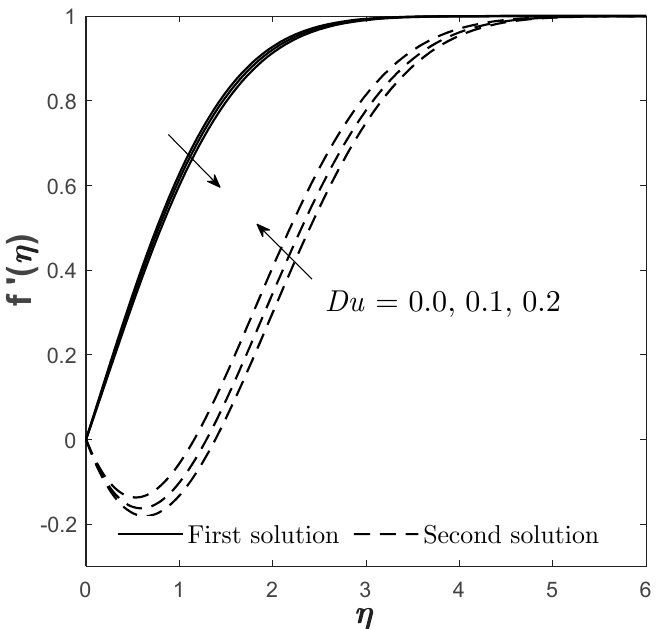
Figure 14. Plots of f (cid:48) ( η ) for varied Du when N = Rd = Sc = Sr = 1, λ = − 1, φ 2 = 0.01, and Bi = 0.1.